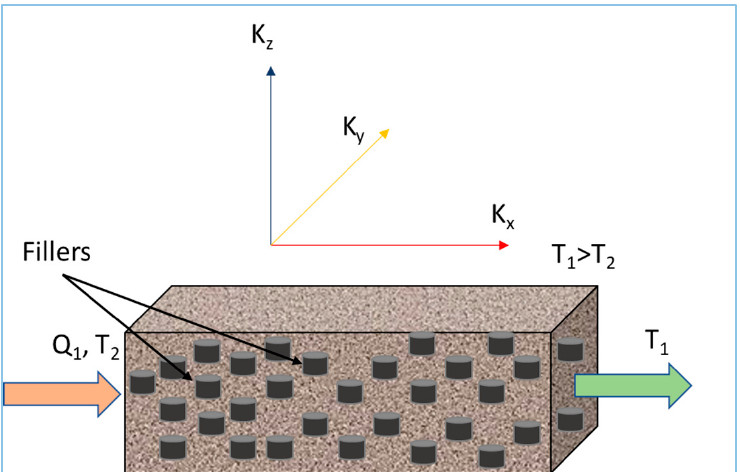
Figure 2. Showing three thermal conductivities as anisotropic properties along x, y, and z directions.